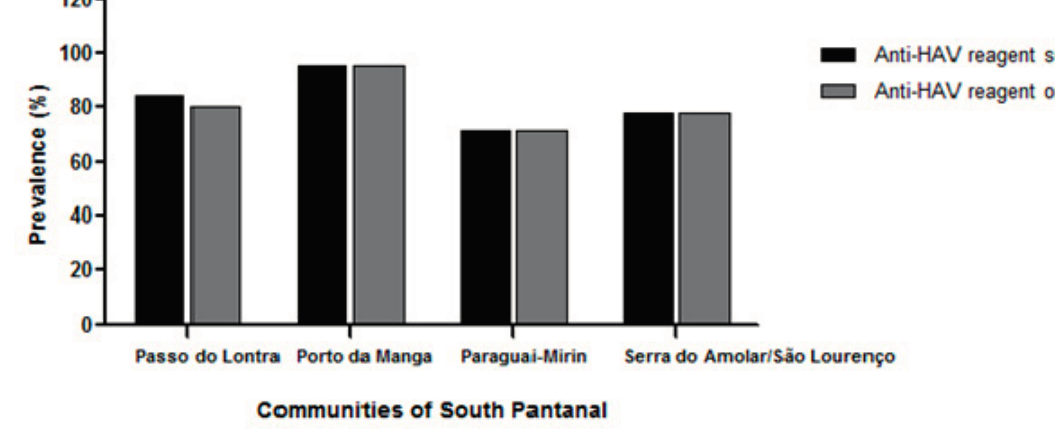
Figure 3. Total anti-HAV prevalence in serum and oral fluid by communites from individuals linving in difficul-to-access areas of South Pantanal,